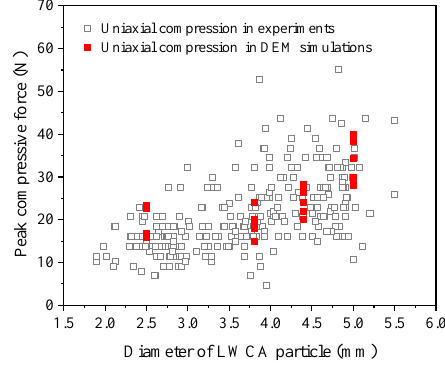
Fig. 4. Relationship between peak compressive force and LWCA particle size under uniaxial compression test.